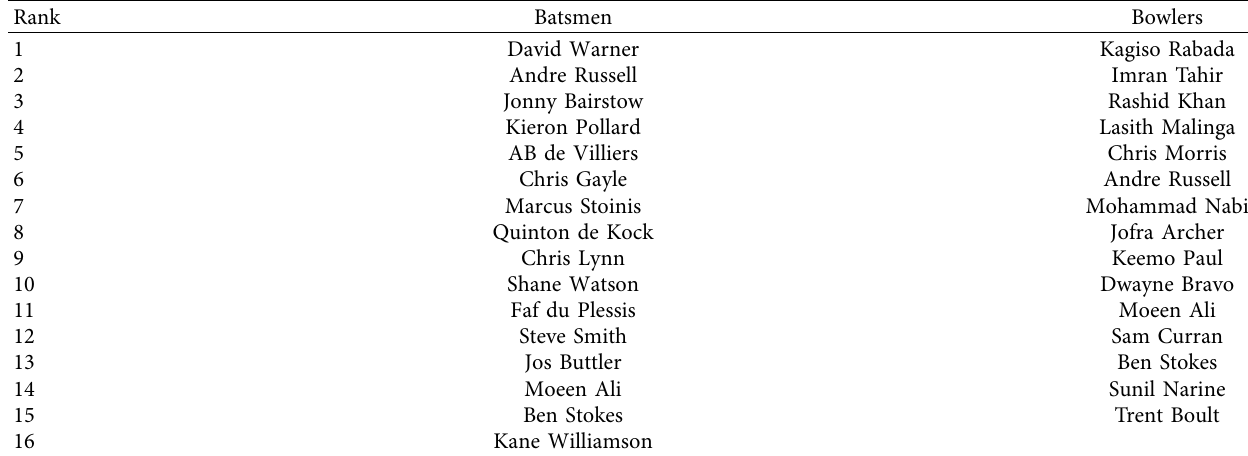
Table 11: Ranks generated by